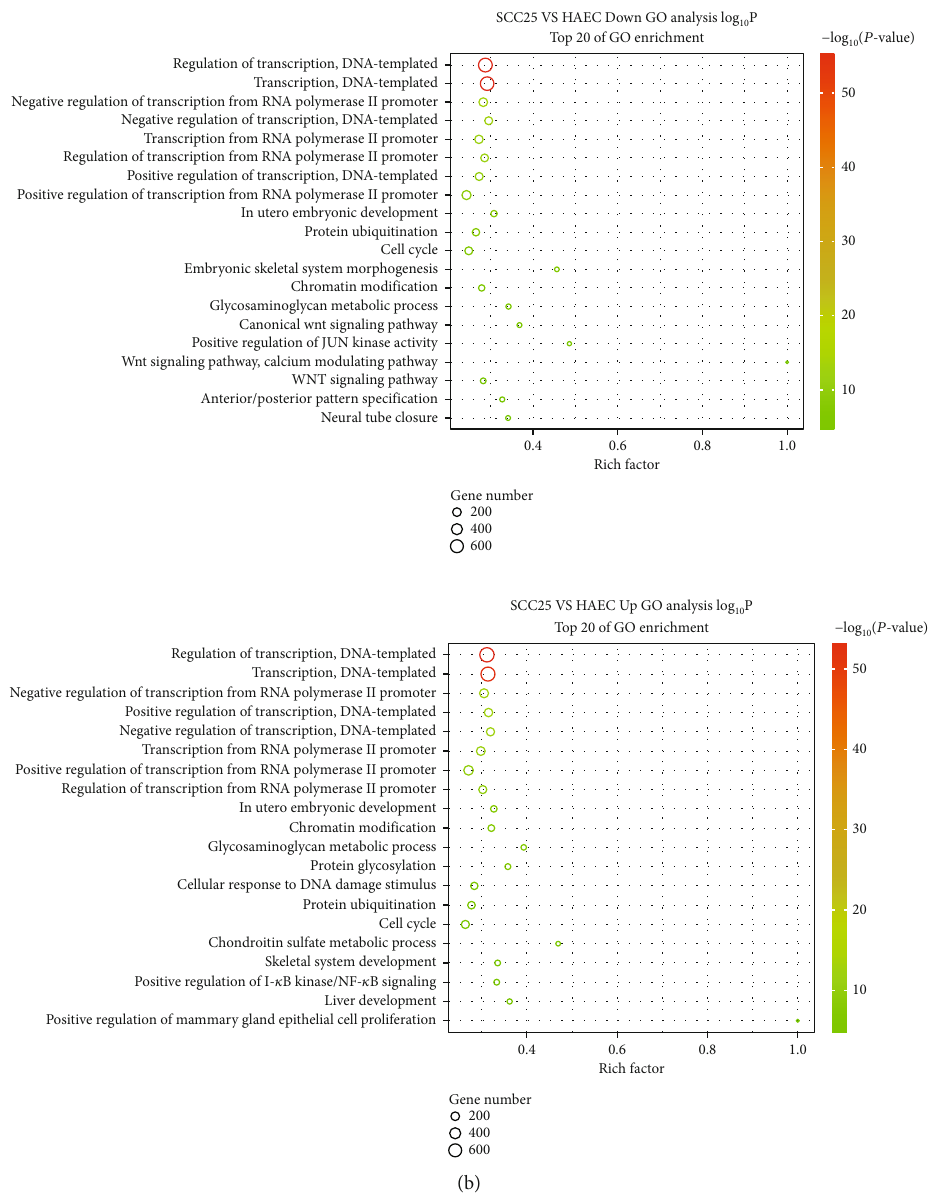
Figure 6: Gene Ontology (GO) enrichment analysis. (a) GO enrichment analysis aimed to obtain signi fi cantly enriched GO entries to show gene functions that might be regulated by transcription factors. Each peak-neighboring gene was annotated with GO to harvest all of its GO function entries, and all peak-neighboring genes were assigned to di ff erent levels of MF (molecular function), BP (biological process), and CC (cellular component). In the GO functional classi fi cation, Fisher ’ s exact test was adopted to calculate the signi fi cance level of gene enrichment in each GO classi fi cation to screen out the GO classi fi cations that were signi fi cantly enriched in the peak-neighboring genes. The top 15 items of GO items that were signi fi cantly enriched in the peak-neighboring genes were selected as a histogram, and the signi fi cance threshold was P value < 0.05. The horizontal axis histogram was taken as an example to display the GO enrichment analysis of all peak-neighboring genes. On the leftmost was BP, in the middle was MF, and on the rightmost was CC. The horizontal axis of each graph was -log10 ( P value), and the vertical axis was the name of the GO items. (b) The results of the GO enrichment analysis of peak- neighboring genes were presented in a bubble chart format, with the top 20 GO entries that were signi fi cantly enriched in peak- neighboring genes displayed. In the fi gure, the ordinate indicated the GO entry, and the abscissa marked the rich factor. The size of the dot in the fi gure indicated the number of peak-neighboring genes enriched on the GO entry, and the color illustrated the signi fi cance P value of the GO entry. The smaller the P value, the smaller the enrichment and the more signi fi cant the set. The degree of the GO enrichment was measured using the rich factor, P value, and the number of genes enriched in this GO entry. Among them, the rich factor referred to the ratio of the number of peak-neighboring genes enriched in the GO entry to the number of all genes annotated to the GO entry. The greater the rich factor, the greater the